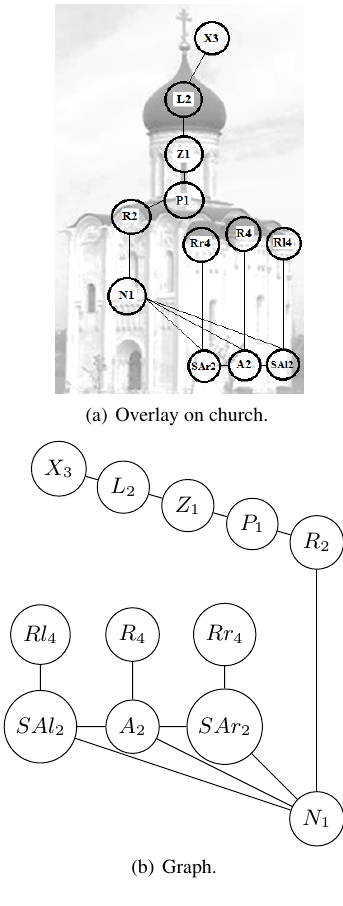
Figure 1: Modeling of the church ”Pokrova-na-Nerli” by its com- ponents. N 1 nave with geometry 1 sacrifice altar right (r) SAr 2 , SAl 2 and left(l) with geometry 2 sacrifice altar roof right (r) Rr 4 , Rl 4 and left (l) with geometry 4